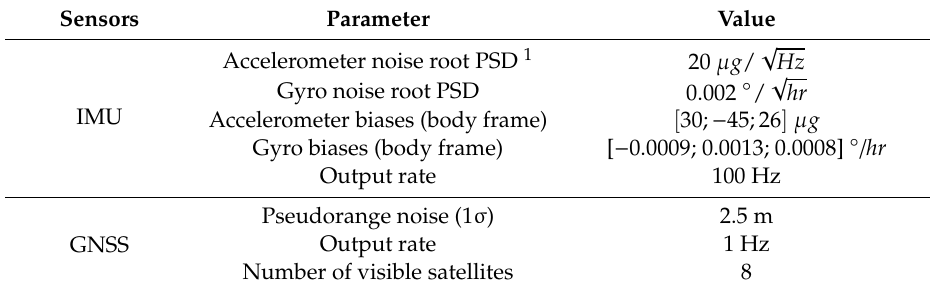
Table 4. Simulation parameters.